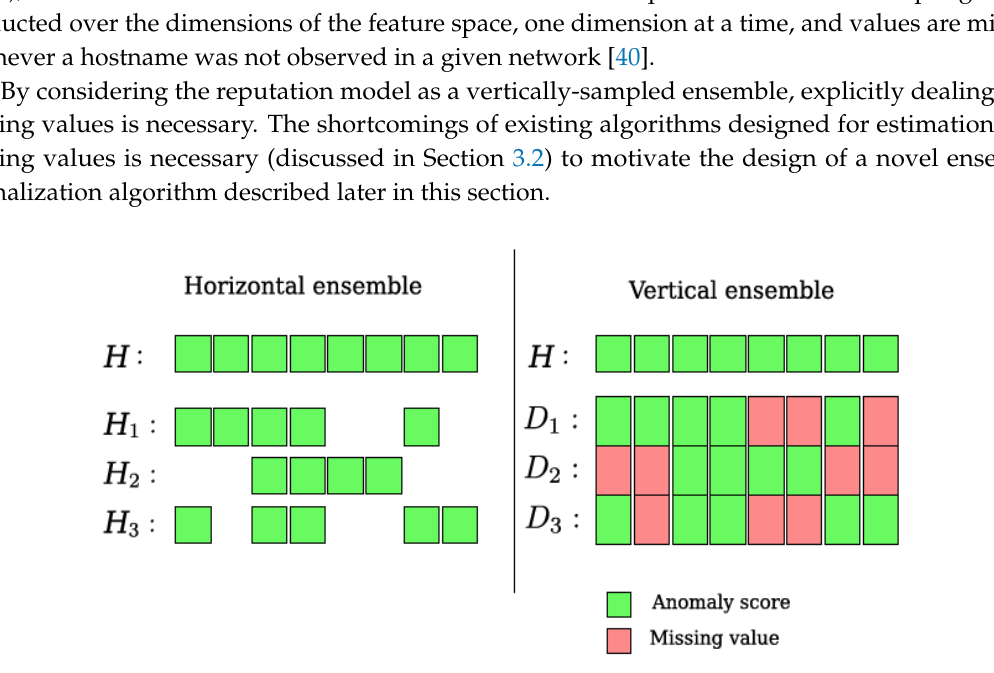
Figure 3. Horizontally and vertically sampled ensemble illustration.